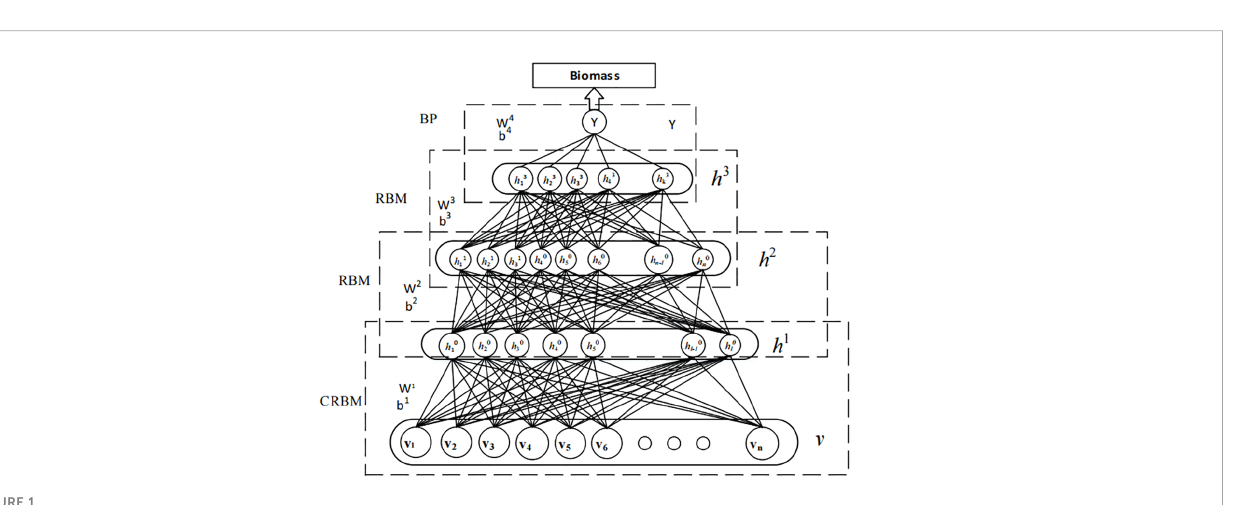
FIGURE 1 Biomass prediction model of nuclear cold source